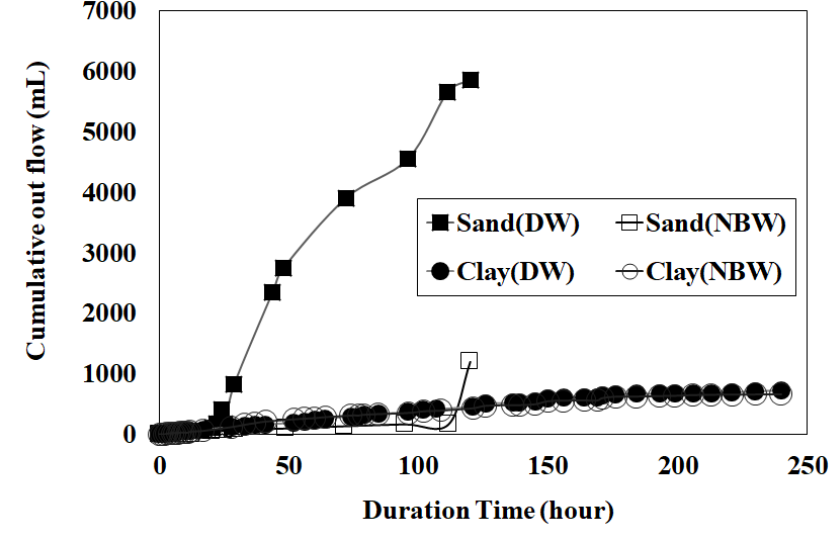
Figure 8. Cumulative flow.